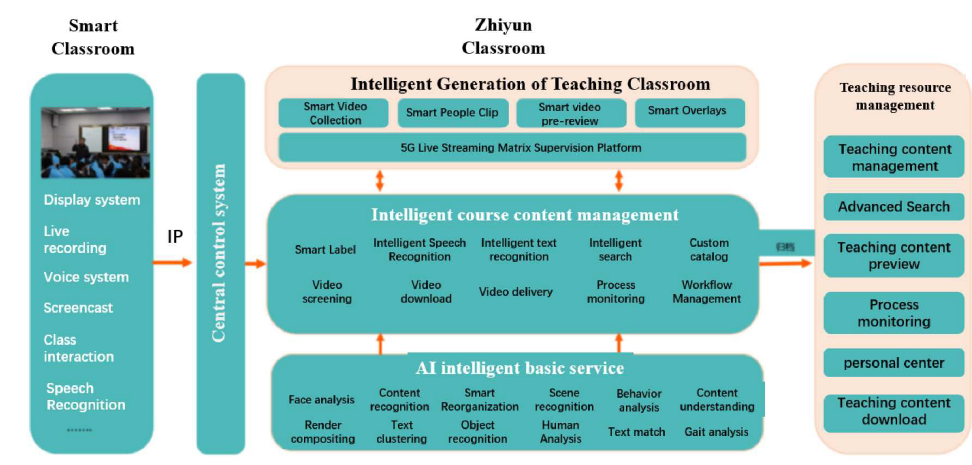
Fig. 2 Data flow of smarter classroom and Zhiyun Classroom.